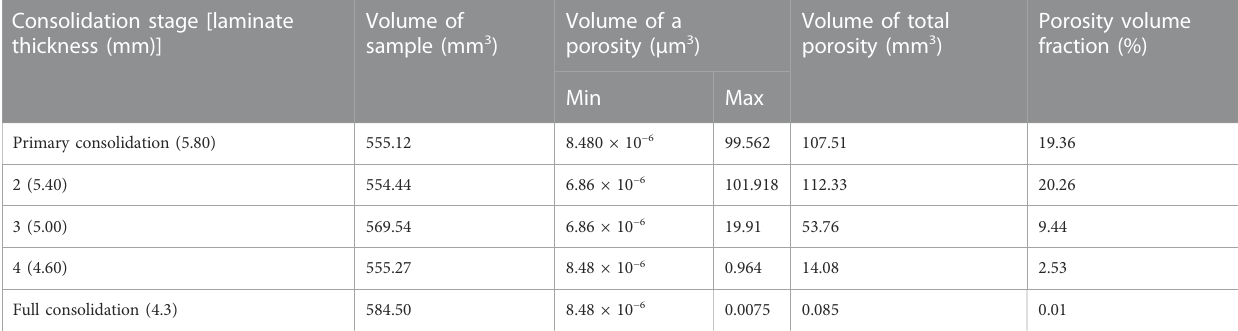
TABLE 4 Porosity volume fractions relative to the corresponding consolidation